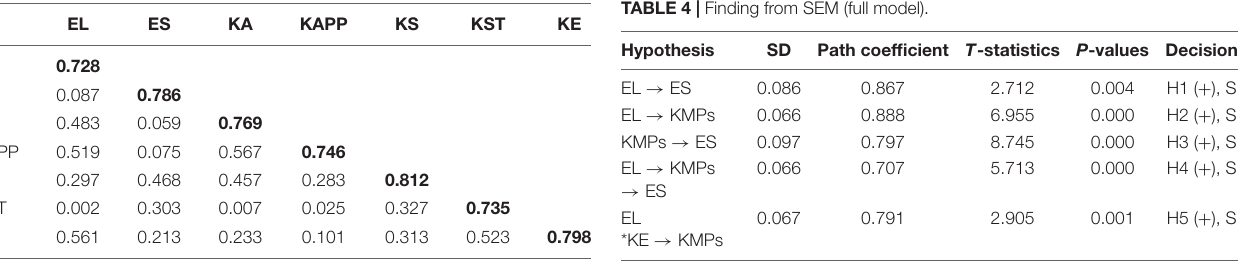
TABLE 3 | Discriminant validity following Fornell and Larcker criteria.